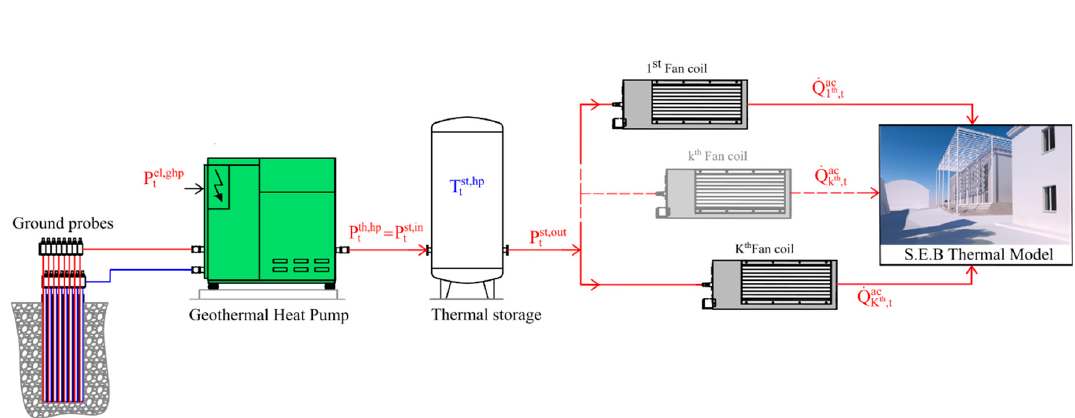
Figure 3. Scheme of the Heating, Ventilation and Air Conditioning System (HVAC) plant.